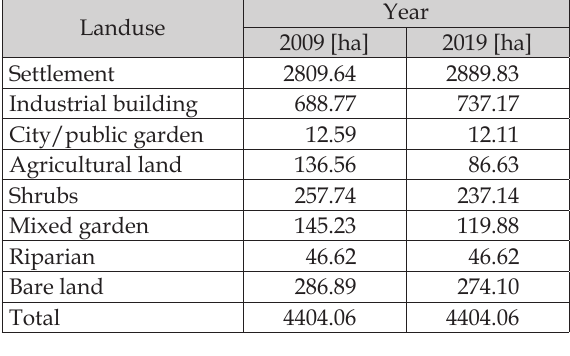
Table 1. Comparison of landuse area in Surakarta City in 2009 and 2019 (acc. to Statistical Bureau of Indonesia (Badan Pusat Statistik 2019).